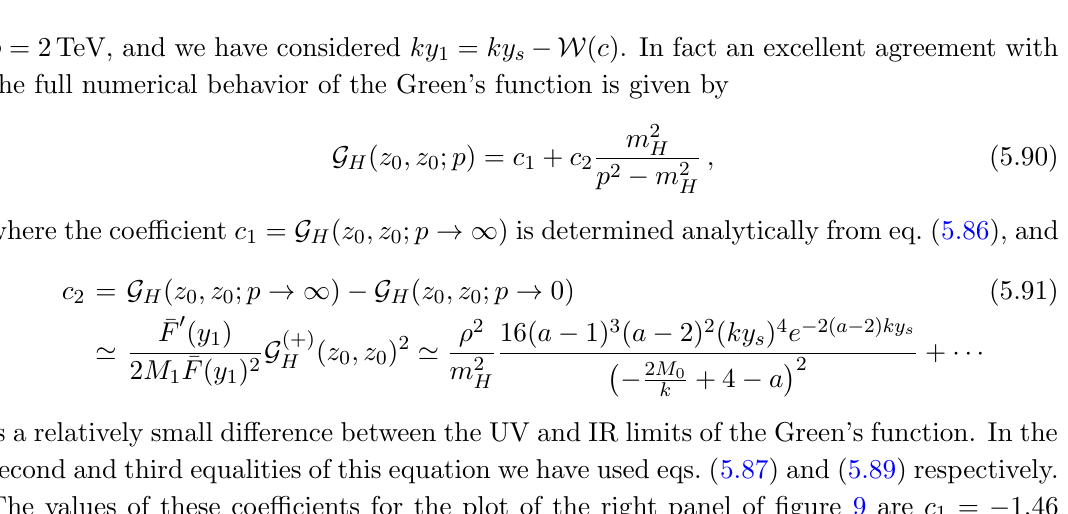
Table 1 . Values of the mass gap for di(cid:11)erent (cid:12)elds where (cid:26) (cid:17) e (cid:0) ky s =y s